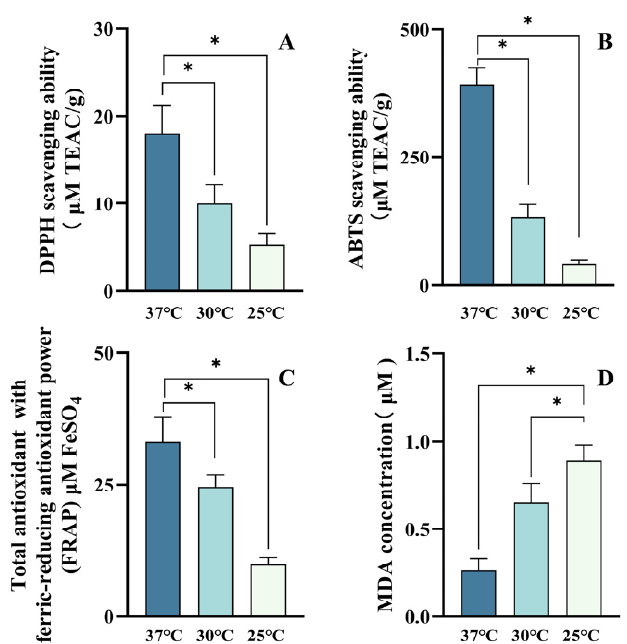
Figure 7. Antioxidant activities of α -/ β -carotenes with different stoichiometries. DPPH scavenging ability ( A ), ABTS scavenging ability ( B ), total antioxidant with ferric-reducing antioxidant power ( C ), and MDA content ( D ) of α -/ β -carotenes with different stoichiometries produced under different temperature cultivations at starting stage and cold shock treatment at end stage. (*) p < 0.05.